Question: Generate an informative caption for the figure above.
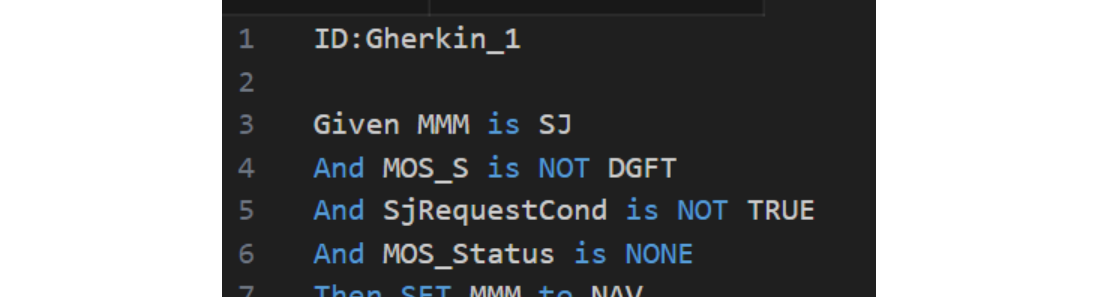
Answer: A requirement written in customized version of the Gherkin    To systematically analyze the contradictions between requirements, we started the process by  creating a dataset. Within these datasets, requirements were rigorously parsed based on the  grammars associated with their respective formats. This parsing process was facilitated using  ANTLR4 (ANother Tool for Language Recognition), a versatile parser known for its ability to  create parsers for various programming languages and data formats [17].